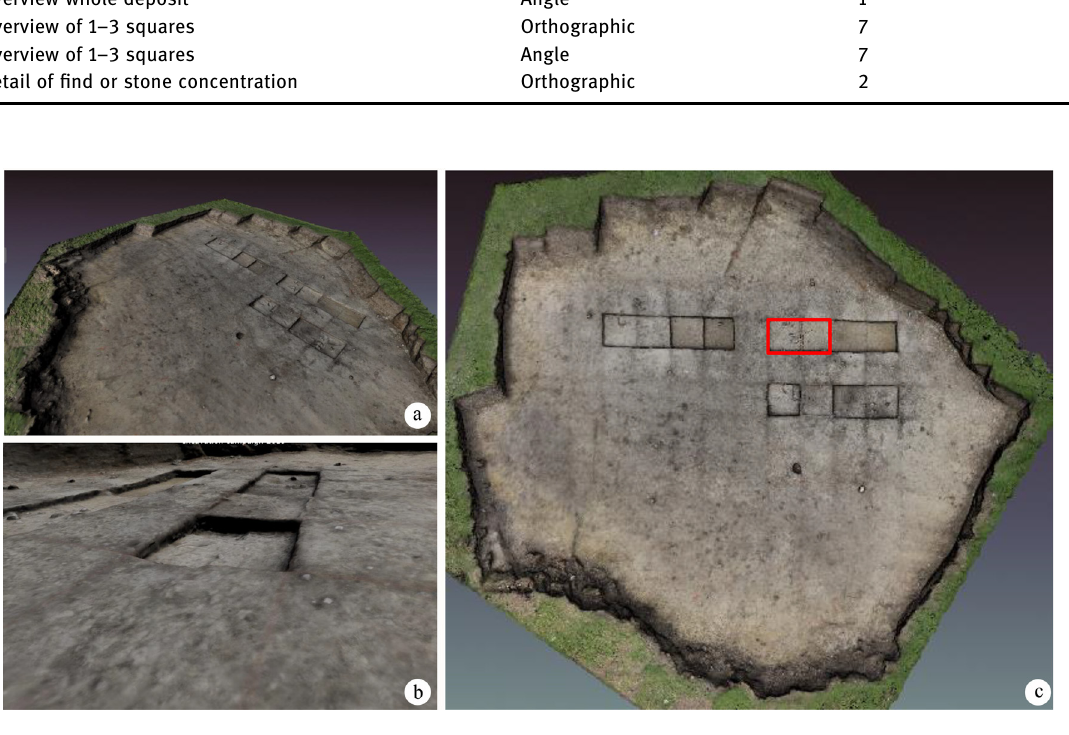
Figure 5: Examples of views used by the students ( Ahnlund Malmberg et al., 2019; Petersén et al., 2019 ) ( a ) and ( b ) slightly skewed angled views; ( c ) orthographic